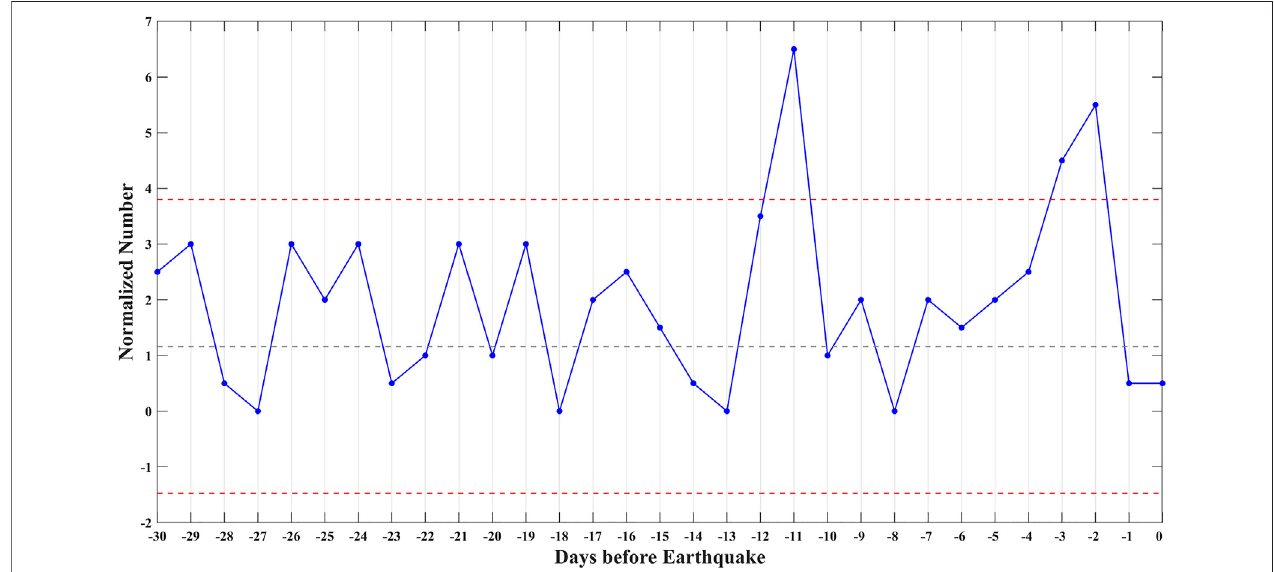
FIGURE 10 | Summed number of anomalies with 300 km distance from epicenter for real earthquakes. X -axis represents the days before earthquakes. Y -axis representsthetotalnumberofthedatain fi rstthreelinesin Figure9 .Thegraydashlineisthemeanvalue( M )ofrandomearthquakesresultsinall31 days.Reddashlines are the upper and lower thresholds with M ± 2* std , where M and std are the mean value and standard deviation of random earthquakes results in all 31 days,